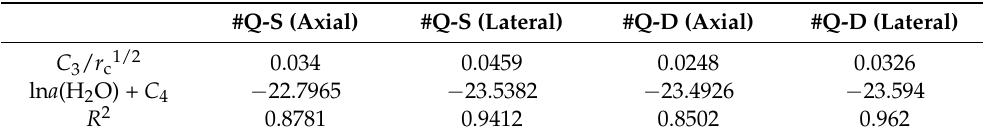
Table 1. C 3 / r c1/2 and In a (H 2 O) + C 4 in axial and lateral fitting relationships of dry and saturated quartz sandstone